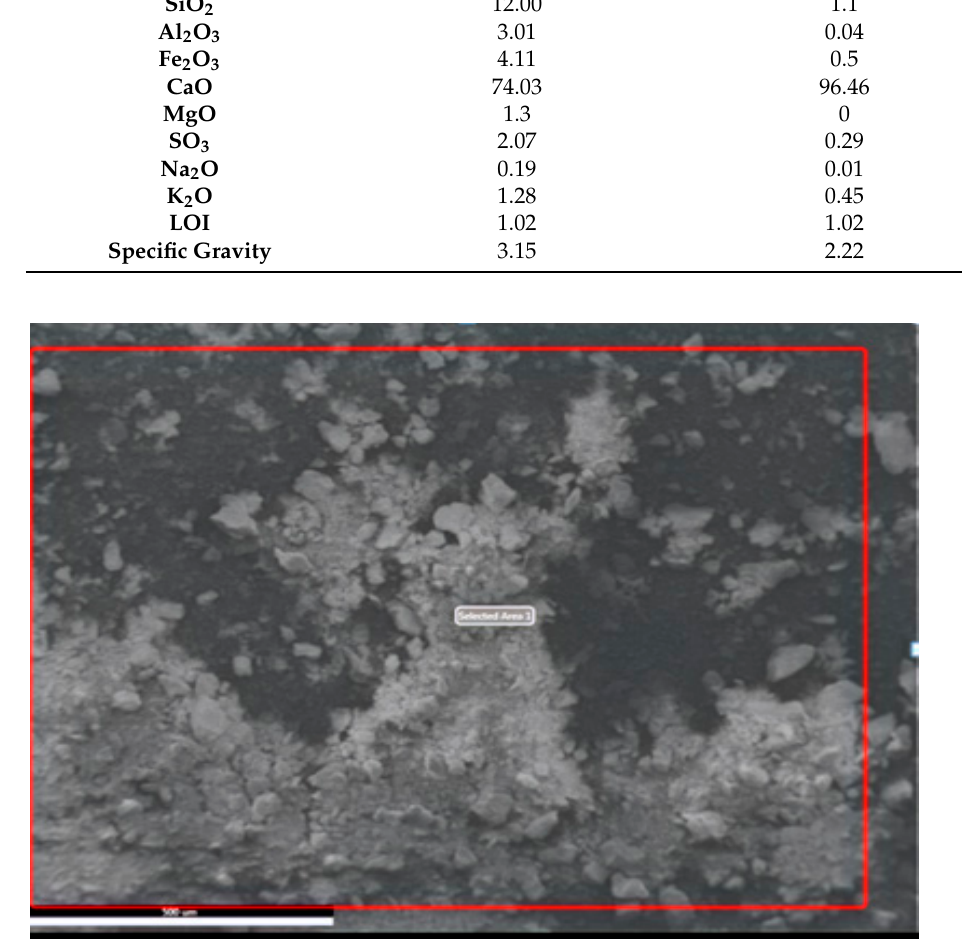
Figure 1. Microstructural morphology of CCR.